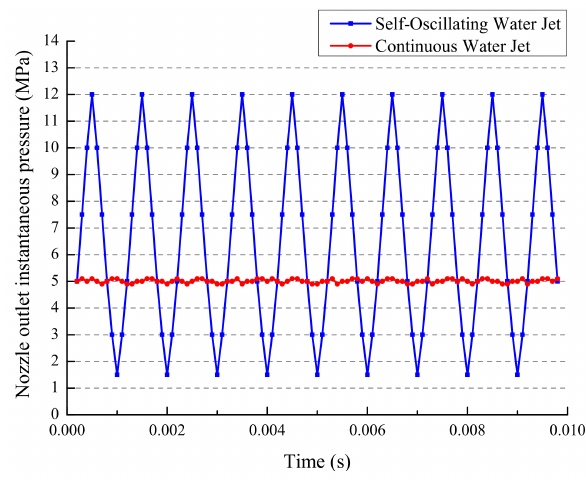
Figure 4. Pressure curves of the pulsed water jets.